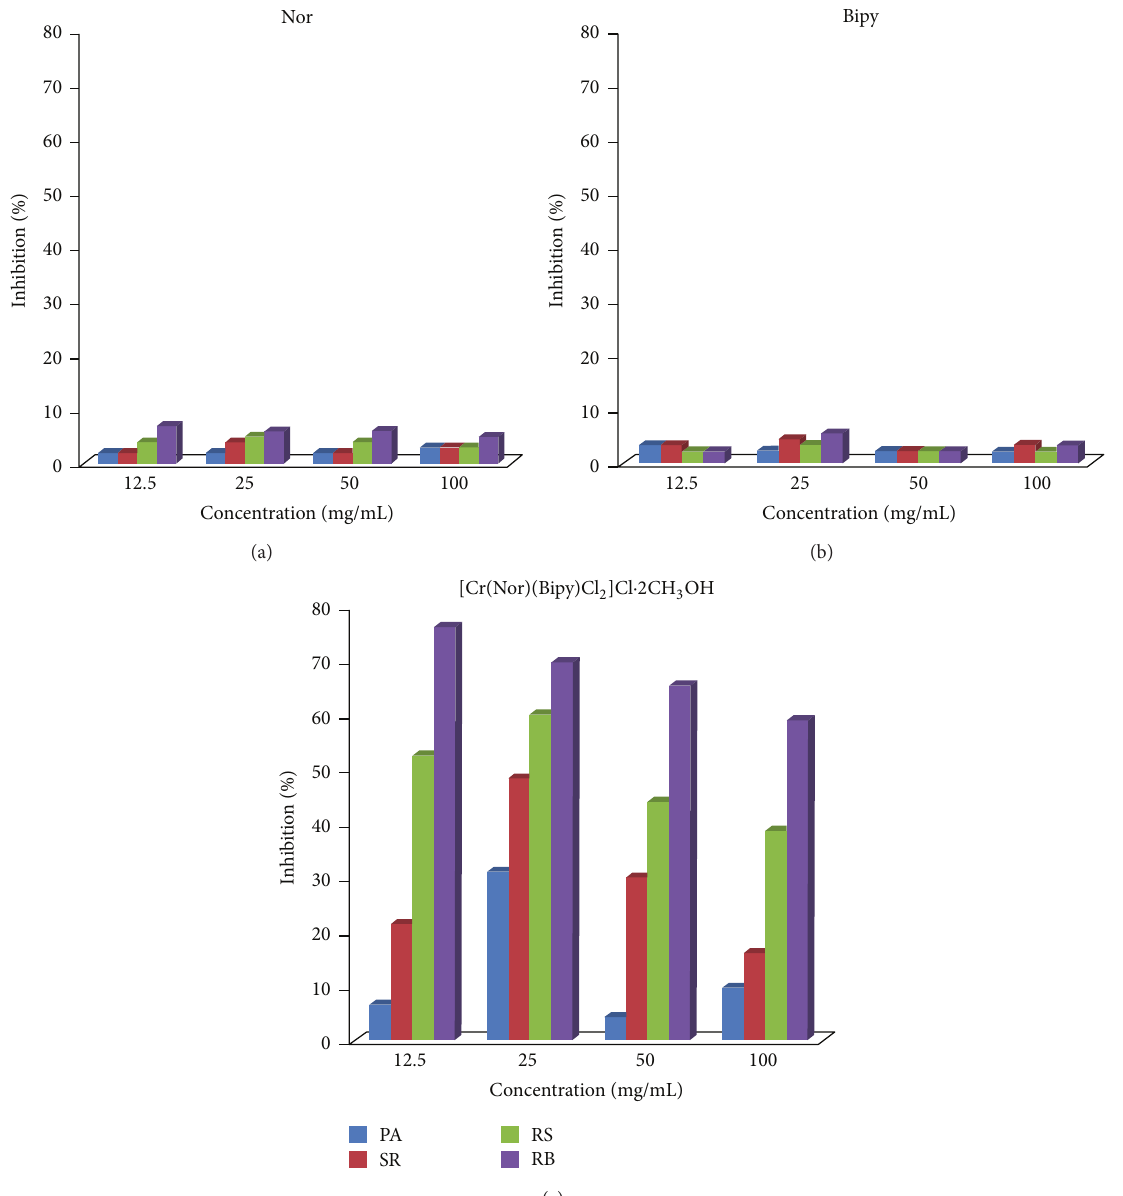
Figure 4: Percentage inhibition of (a) Nor, (b) bipy, and (c) [Cr(Nor)(Bipy)Cl 2 ]Cl ⋅ 2CH 3 OH against PA, SR, RS, and RB.